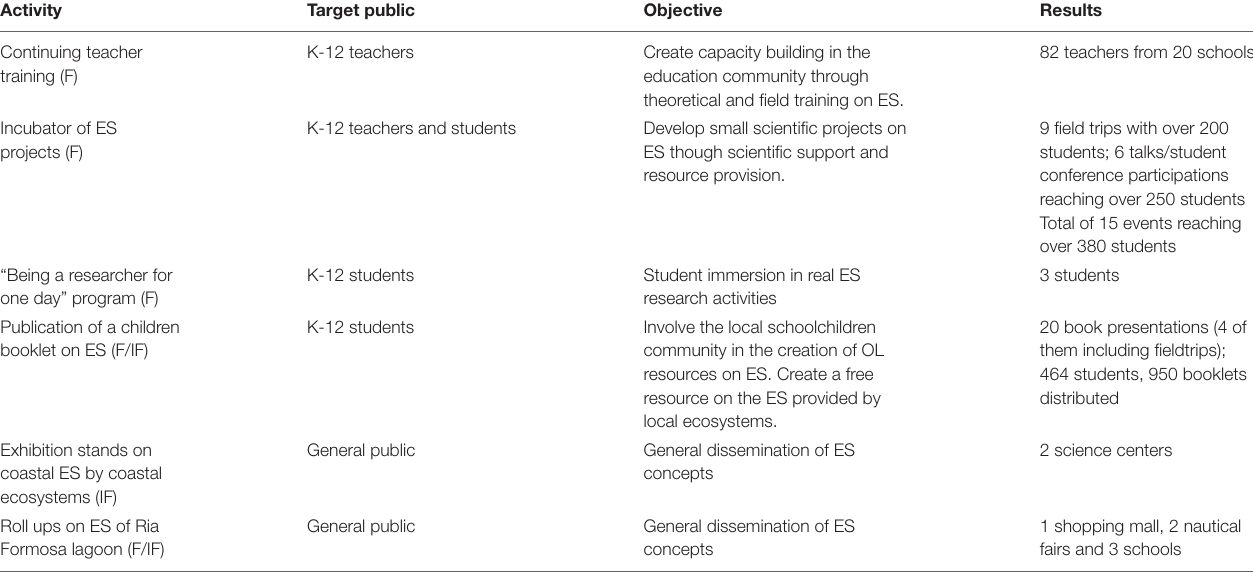
TABLE 2 | Activities conducted by the REASE network to mainstream the concept of ecosystem services (ES) in the western Algarve region (Portugal), including the target public, objective, and results obtained in the first